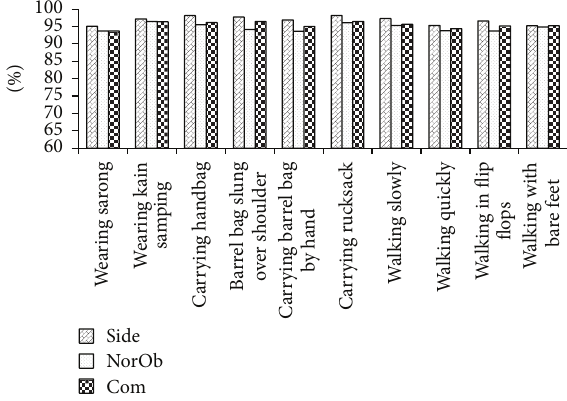
Figure 13: CCRs of individual covariate factor for MMUGait Covariate DB.